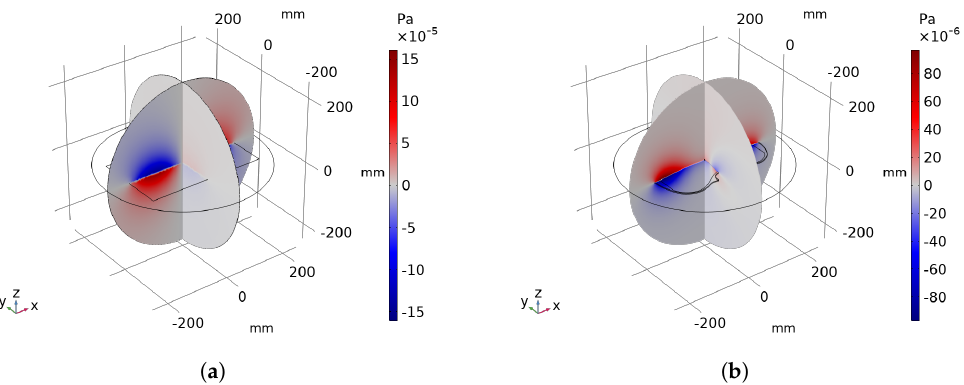
Figure 4. 3D pressure radiation example of a rectangular plate ( a ) and a violin top plate ( b ) computed by the Pressure Acoustics, Frequency Domain study of COMSOL Multiphysics ®